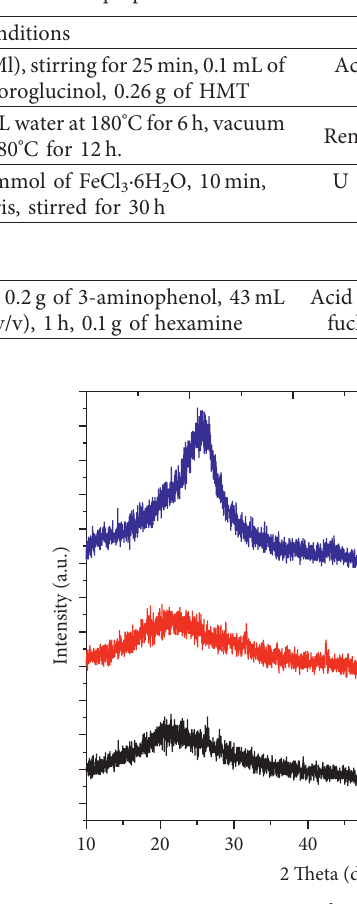
Table 1: List of some previous work prepared of